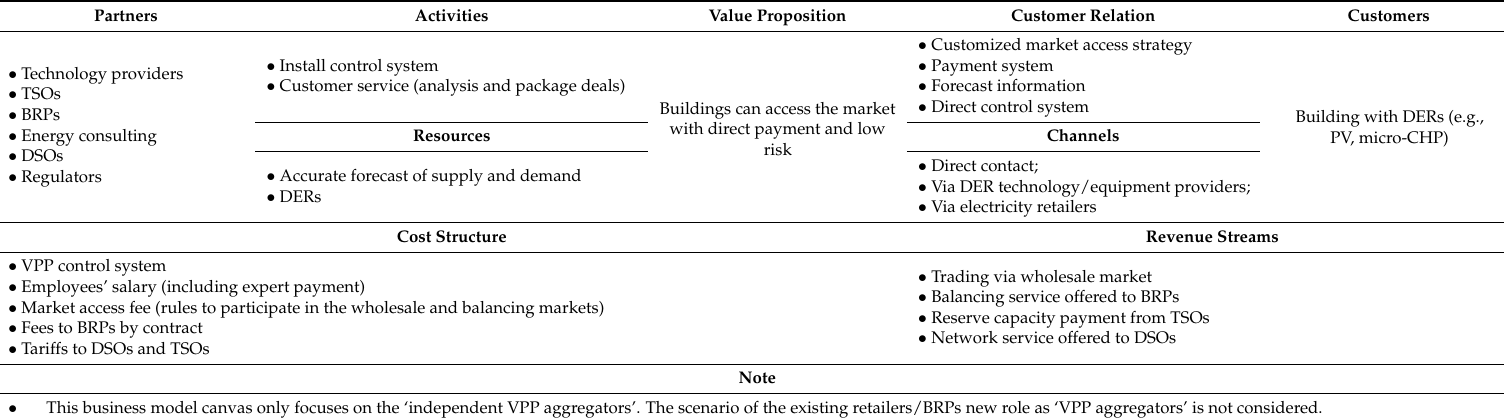
Table 10. Business Model 4- buildings access the energy market via VPP aggregators by providing